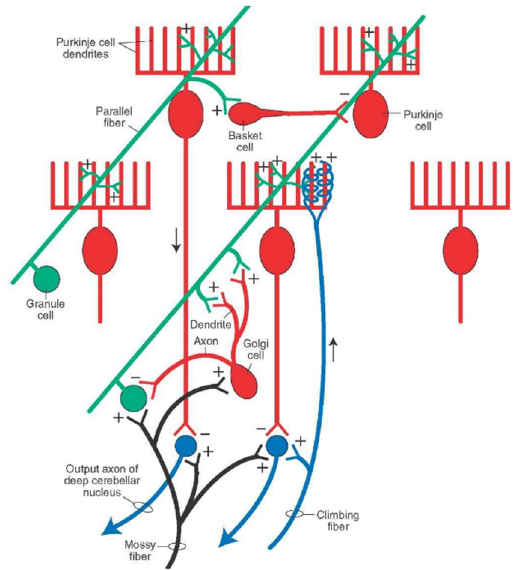
Figure 4. Neural circuit of the cerebellar cortex. The neurons indicated by green or blue are excitatory neurons, whereas the neurons indicated by red are inhibitory neurons.